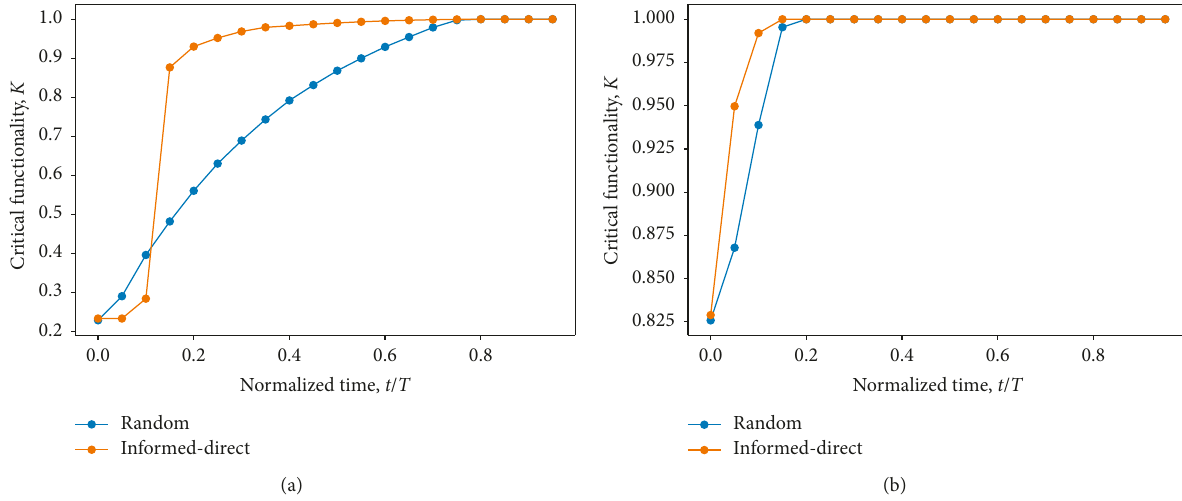
Figure 6: Performance comparison between the informed recovery strategy (direct reporting mode) and random recovery strategy for the initial disruption D equals to (a) 25% and (b) 5%. The process of receiving information is reflected during the early phase of the informed strategy in (a). The performance is not increasing during the phase. After that, the performance jumps significantly after it starts repairing nodes by prioritizing the highest gain nodes to be repaired first. In (b), the performance between these two strategies does not differ